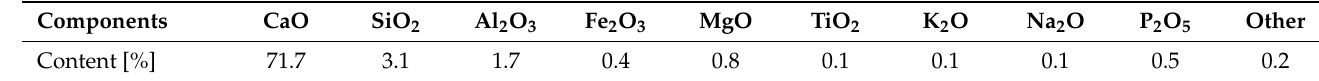
Table 2. Chemical composition of limestone.